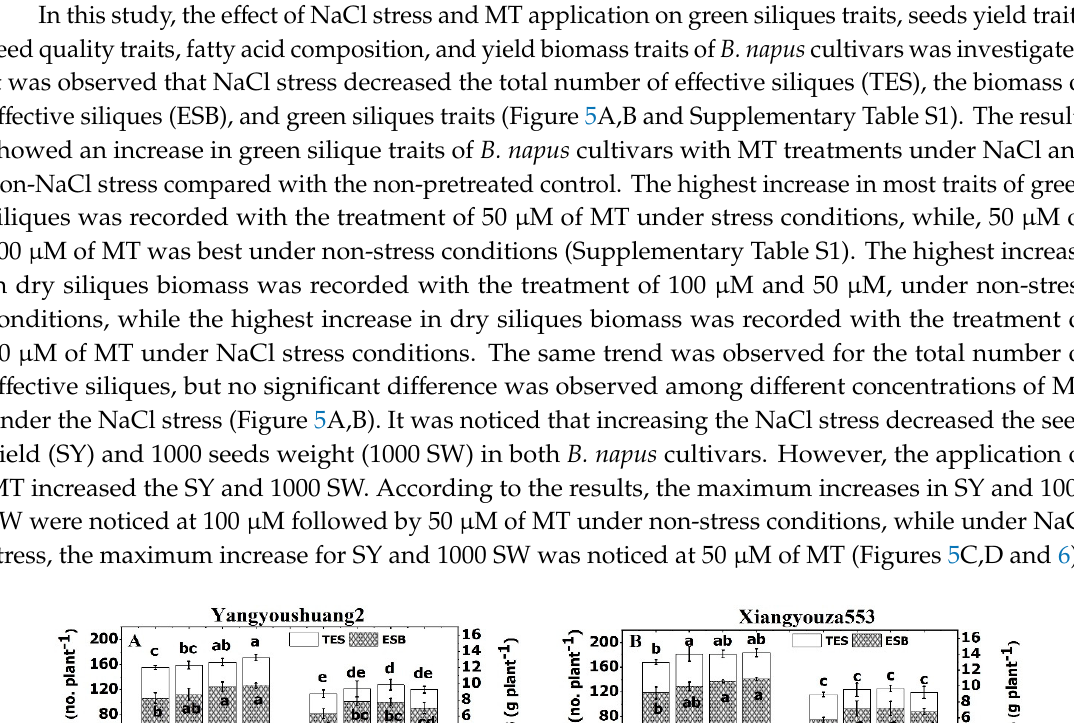
Figure 5. Effect of seed priming in 0 µM (M0), 25 µM (M25), 50 µM (M50), and 100 µM melatonin (M100) on total effective siliques number (TES), effective siliques biomass (ESB), 1000 seed weights